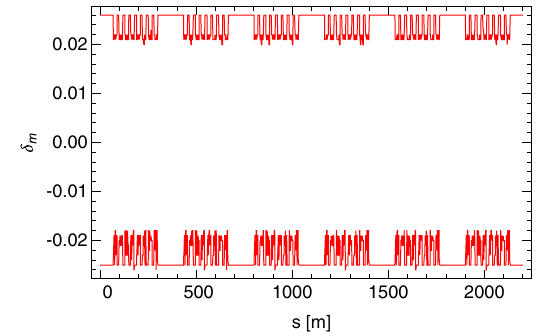
, for PEP-X with ma- m